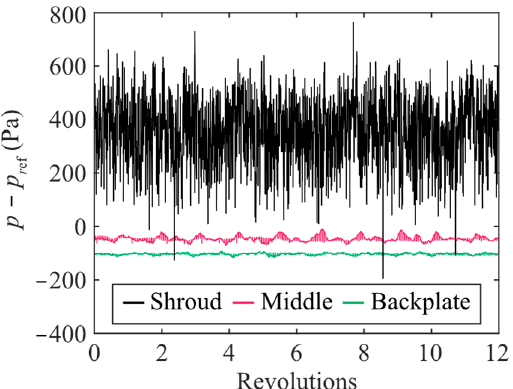
Figure 4. The time history of wall pressure fluctuations at three locations along the BLE.